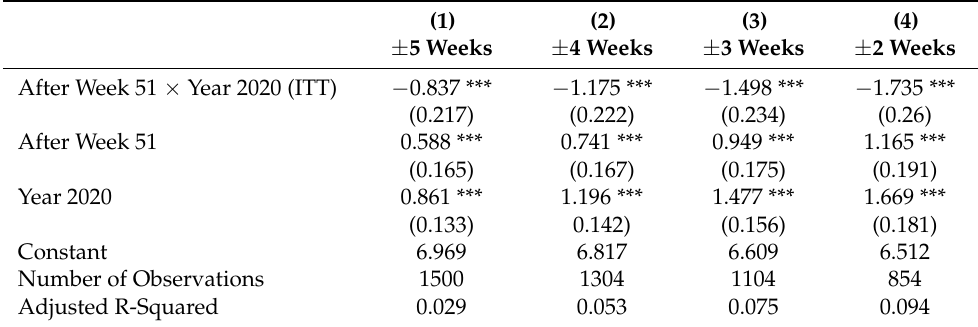
Table 4. RD design combined with difference-in-difference.